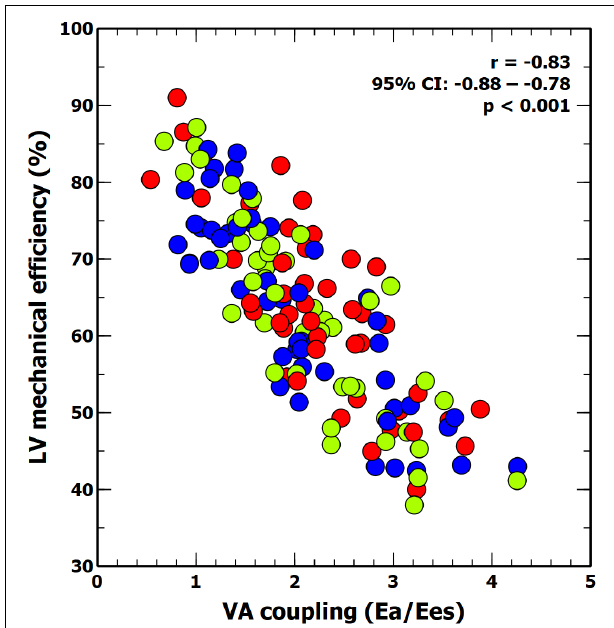
FIGURE 3 | Scatter plot: linear correlation between ventricular-arterial (VA) coupling and LV mechanical efficiency. Colors inside circles represent different experimental interventions: red, afterload; green: preload; blue: